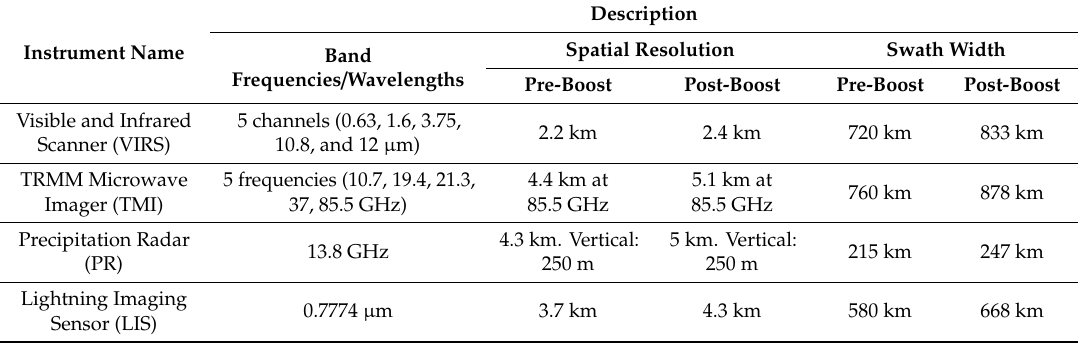
Table 1. Tropical Rainfall Measuring Mission (TRMM) precipitation and lightning instruments. To extend the mission lifetime, the TRMM orbit was boosted to 403 km in August